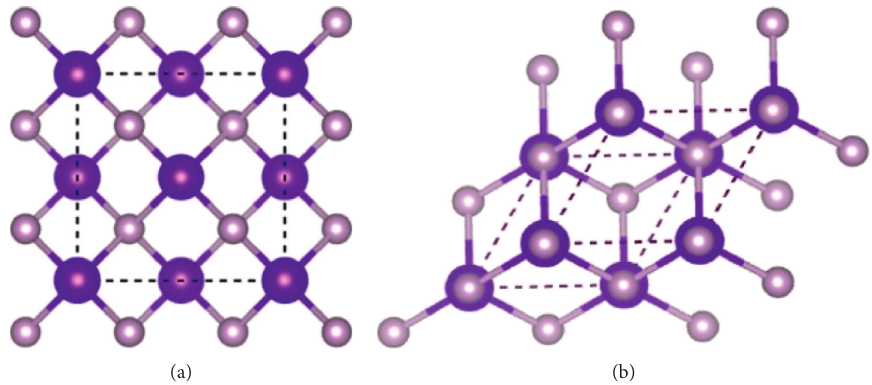
Figure 1: Crystal structure of unit cell of indium phosphide: (a) front view and (b) general